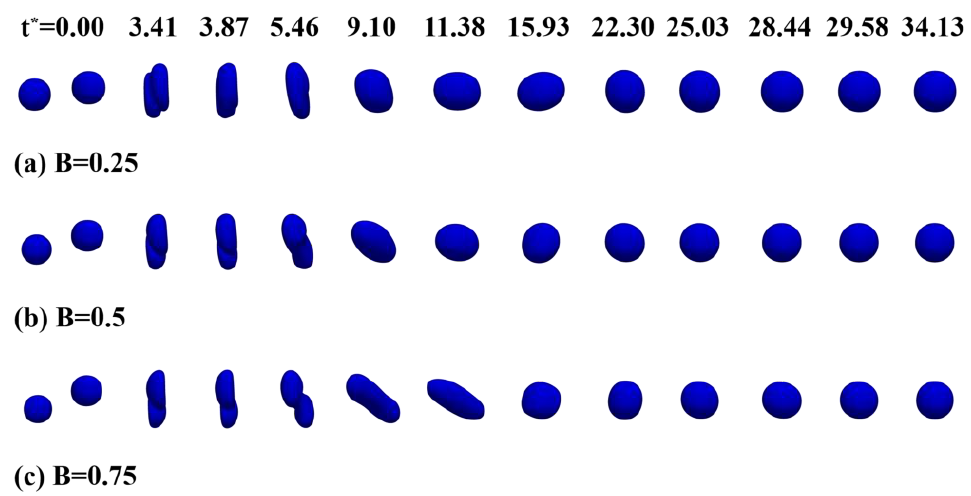
Figure 9. Time evolution of the coalescence of two water droplets in the oil phase under different collision parameters ( a ) B = 0.25, ( b ) B = 0.5, ( c ) B = 0.75.